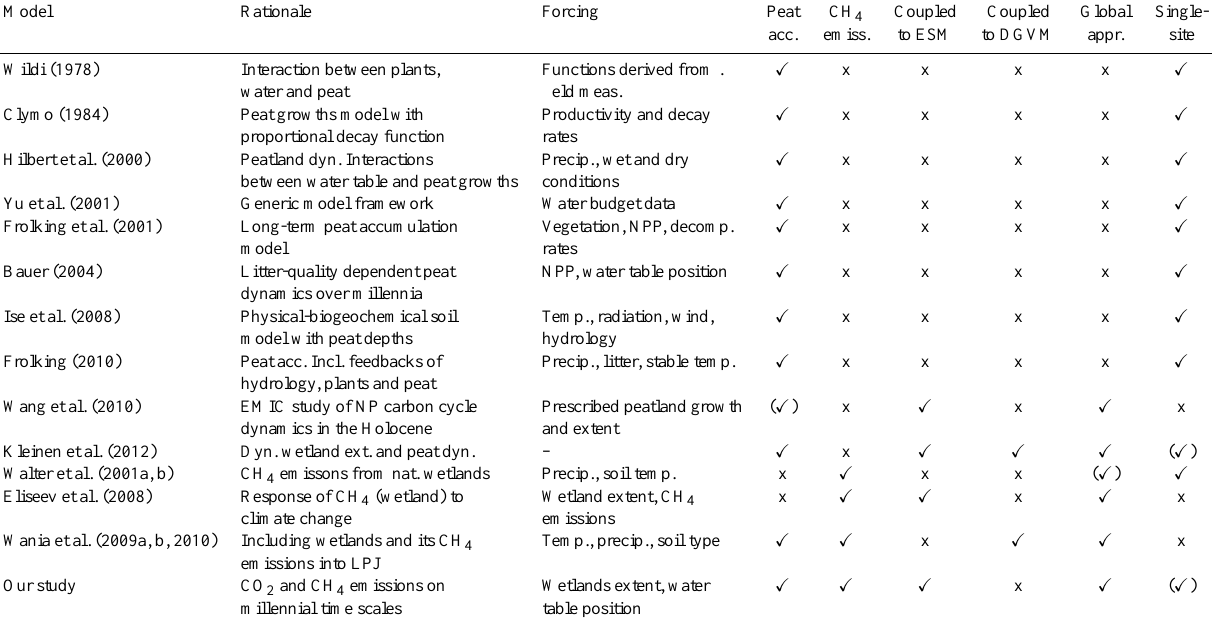
Table 1. Survey of models of peat accumulation and methane